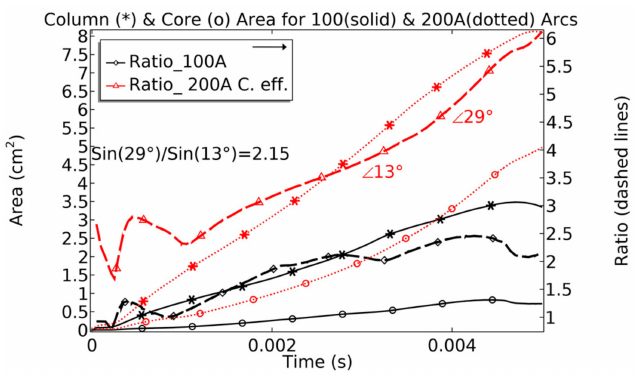
Figure 13. The core area, and the ratio of core-to-column area, for 100 and 200 A peak with(out) thermionic